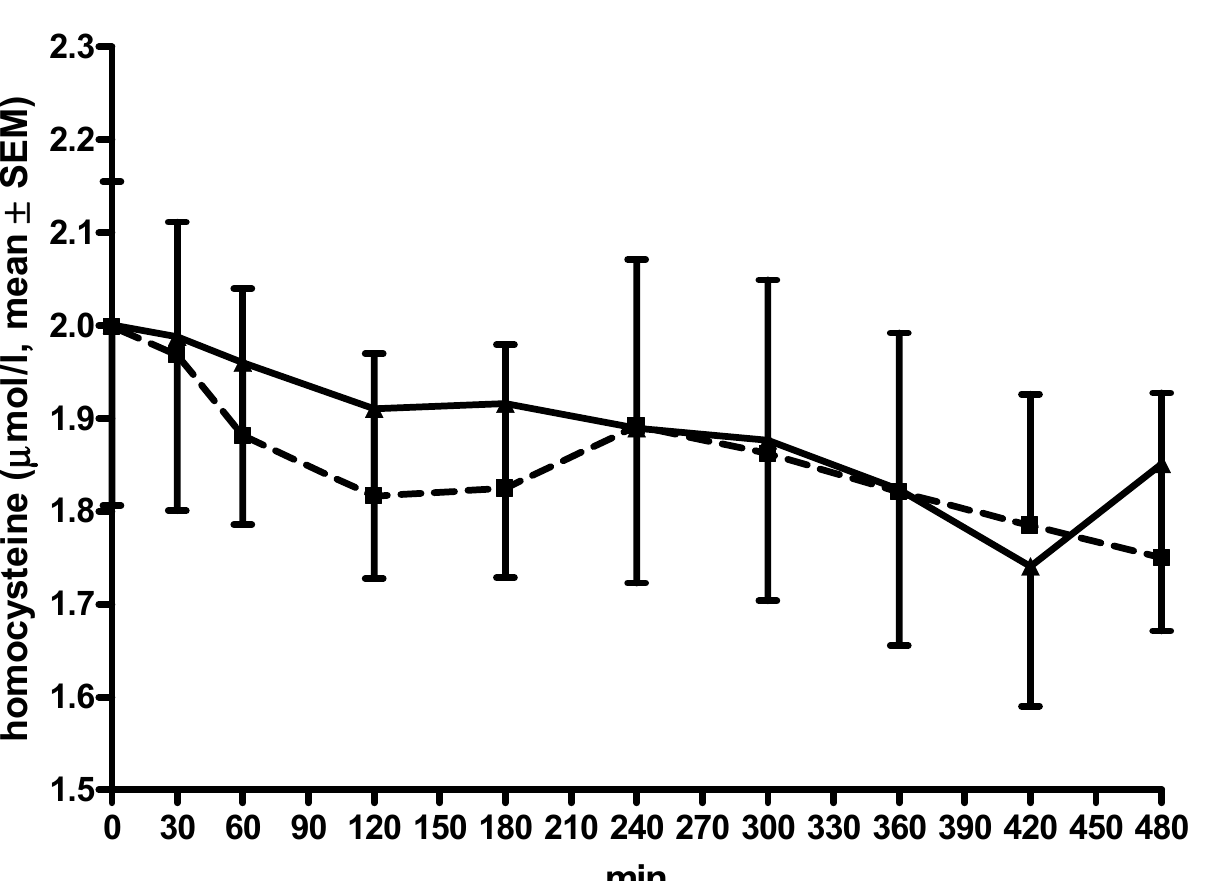
Figure 3. Curve of total homocysteine. All data are given as mean ± standard error of means (SEM); min, minutes; opicapone was taken at − 30 min; thcys concentrations in µmol/L; lines of the L-dopa/carbidopa plus opicapone condition are dashed with (cid:4) ; lines of the L-dopa/carbidopa/entacapone condition are continuous with (cid:78) ; error bars are above the curve of the L-dopa/carbidopa plus opicapone condition; error bars are below the curve of the L-dopa/carbidopa/entacapone condition.